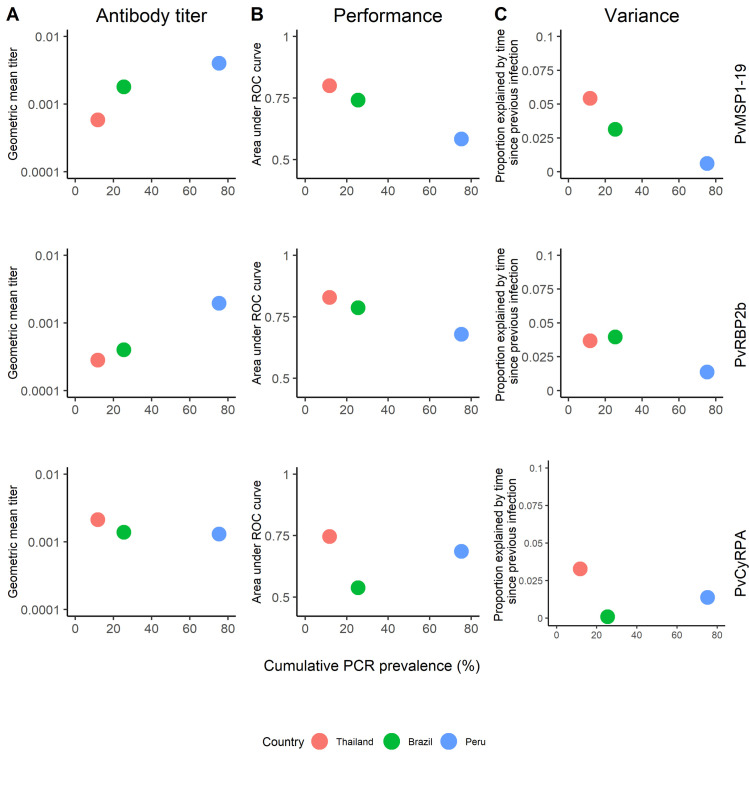
Association of cumulative PCR prevalence and antibody responses to PvMSP119, PvRBP2b and PvCyRPA.(A) Association of cumulative PCR prevalence and the geometric mean titer of antibody responses. (B) Association of cumulative PCR prevalence and the area under the ROC curve. (C) Association of cumulative PCR prevalence and the variance explained by the time since previous infection.